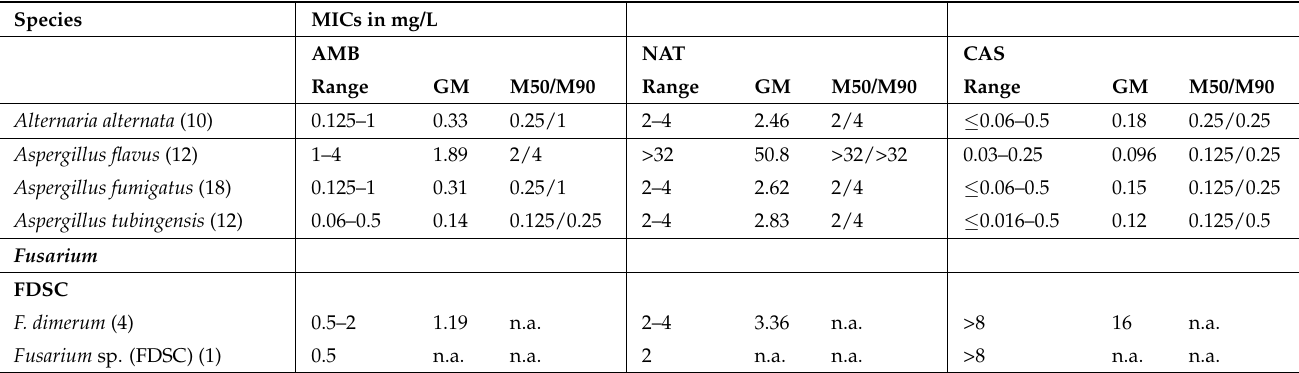
Table 2. Antifungal susceptibility of species isolated from infected eyes against amphotericin B (AMB), natamycin (NAT), and caspofungin (CAS). For the FSSC, the numbering of the phylogenetic species is given in the first bracket.